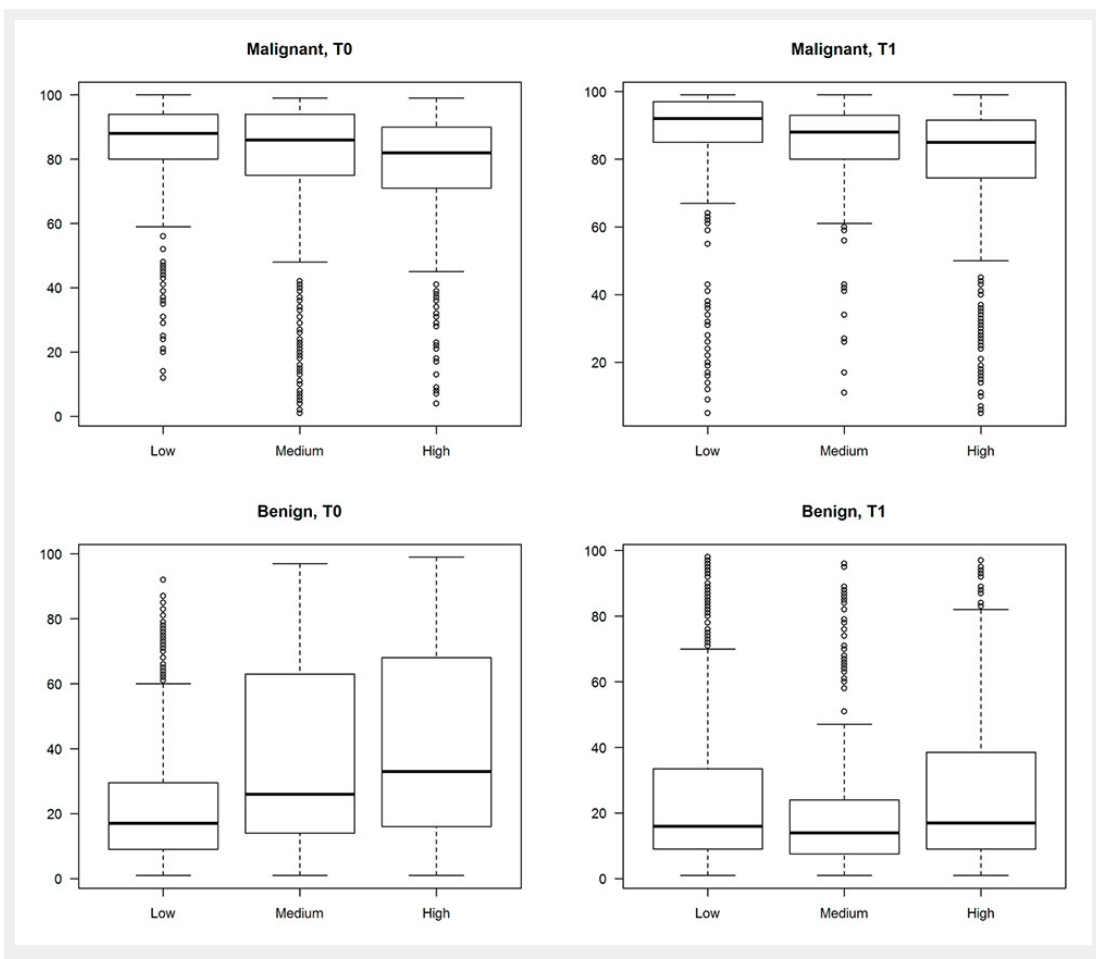
Figure 3 Outcomes by the difficulty level of the pictures and without the pre-defined